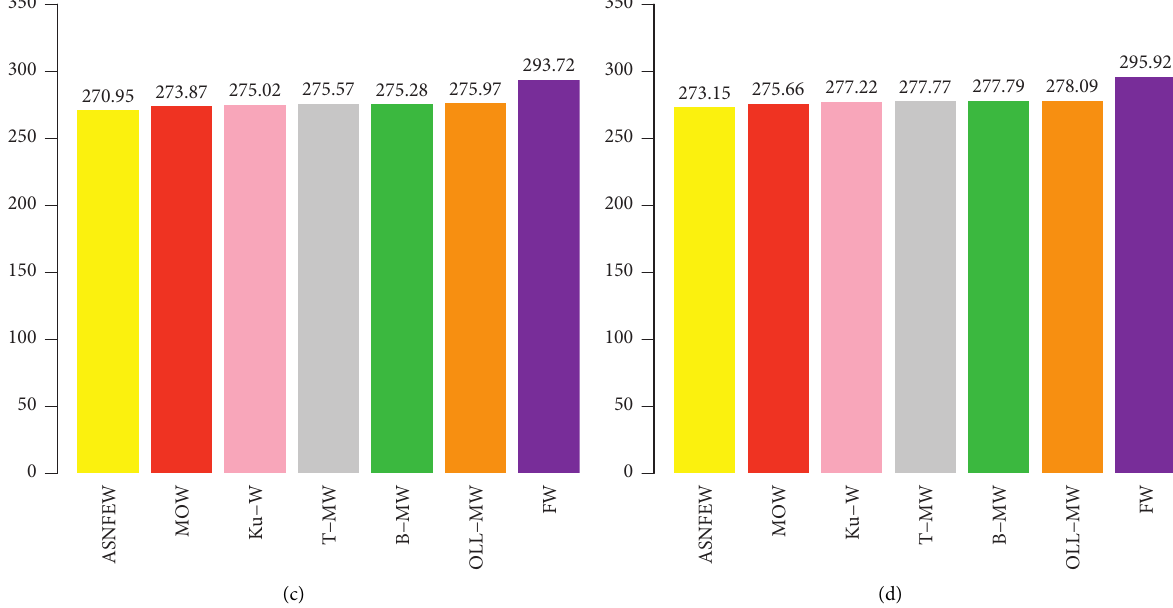
Figure 7: Graphical illustration of the results presented in Table 4. (a) AIC, (b) BIC, (c) CAIC, and (d) HQIC of the fitted models.